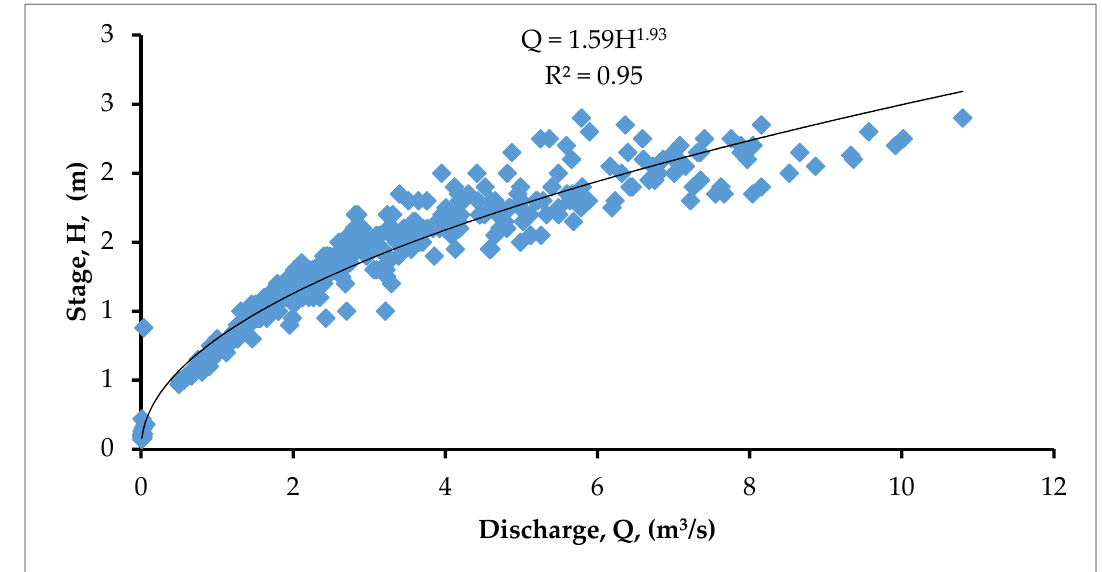
Figure 7. Stage–discharge relationship (rating curve) for Brantie River. From the daily measurement of streamflow recorded at the watershed outlet, a flow duration curve (FDC) was prepared to determine the minimum flow that will exist in the river (Figure 9). The 90-percentile flow (flow exceeded 90% of the time) was 0.028 m 3 /s. This estimate is equivalent to 88.3 hectare-meters of water, and was considered for irriga- tion water availability assessment without the need for a water storage structure for dry season